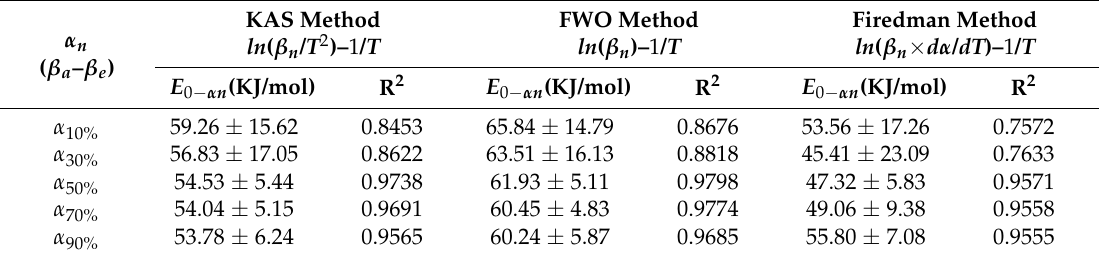
Table 5. The activation energies of Stage 1 obtained under the KAS, FWO, and Friedman